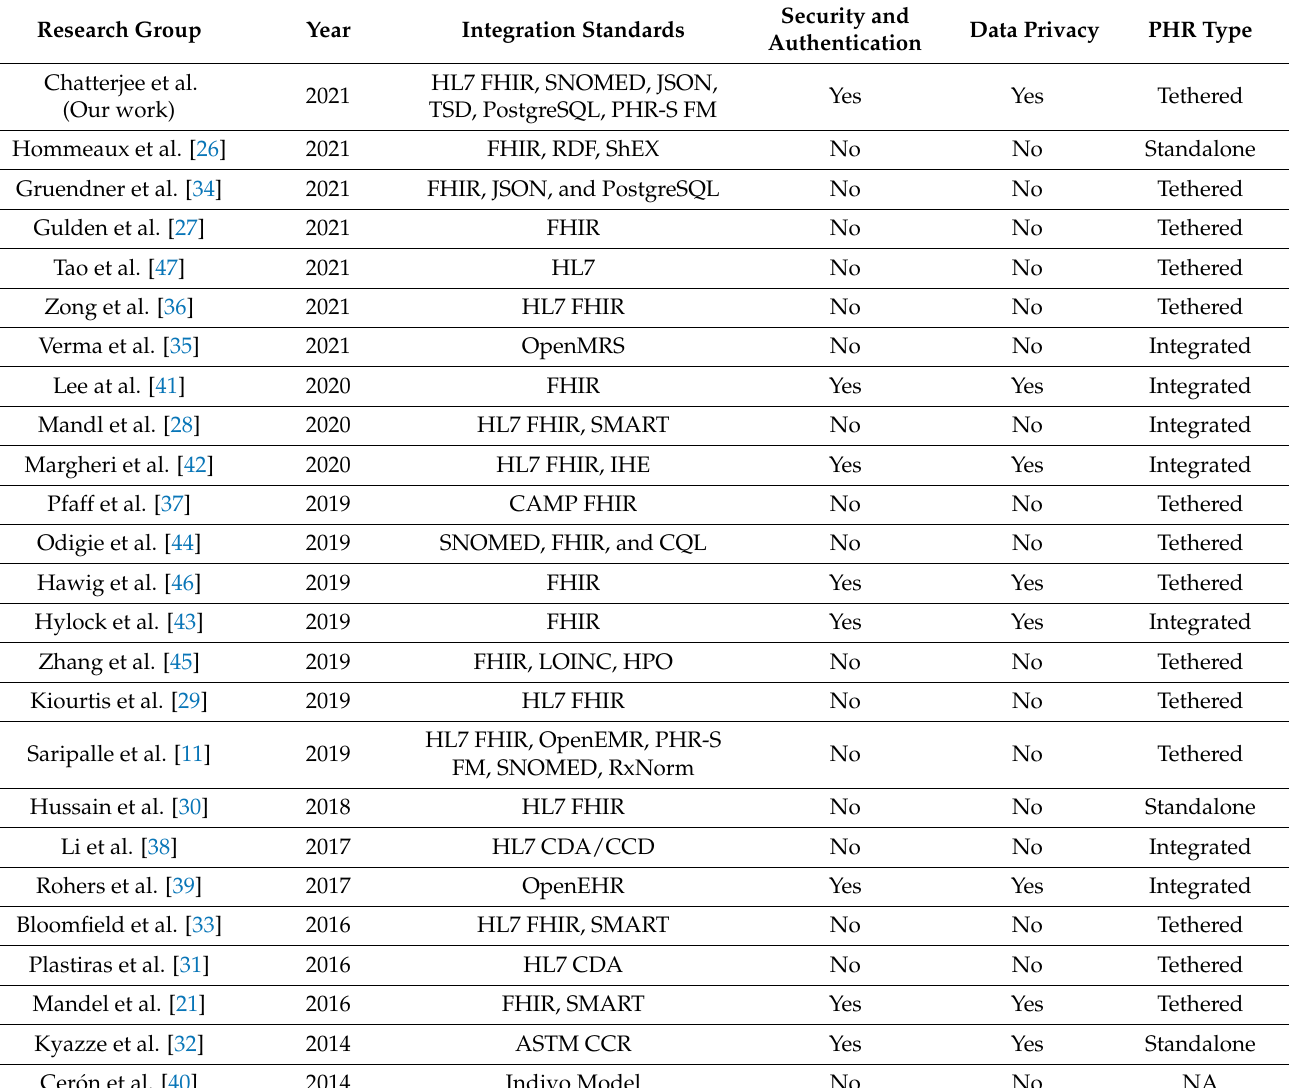
Table 1. Summary of the previous work in comparison to our